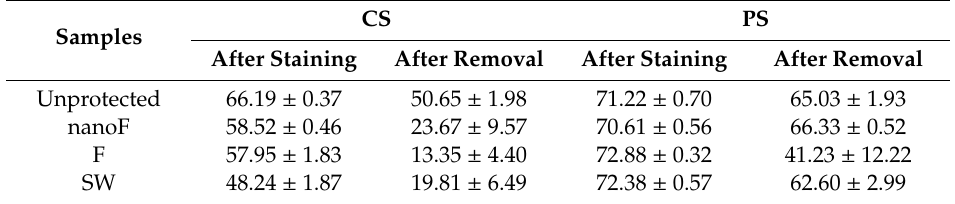
Table 5. Global color difference ( Δ E * ab ) determined after the staining by felt-tip marker and after the cleaning. For each data set the standard deviation is reported.